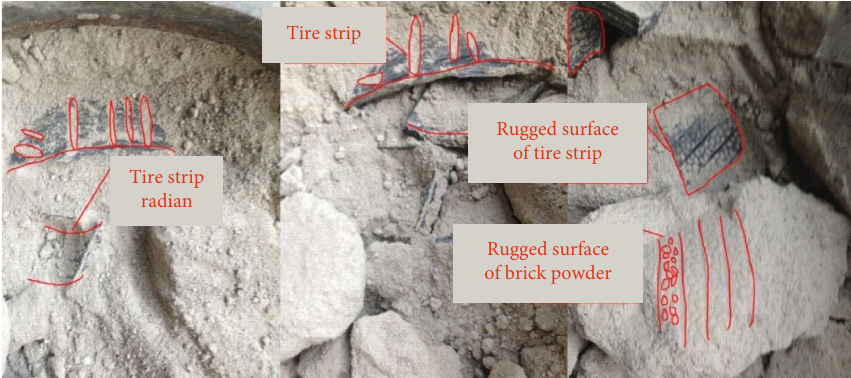
Figure 9: Tire strip and brick powder.